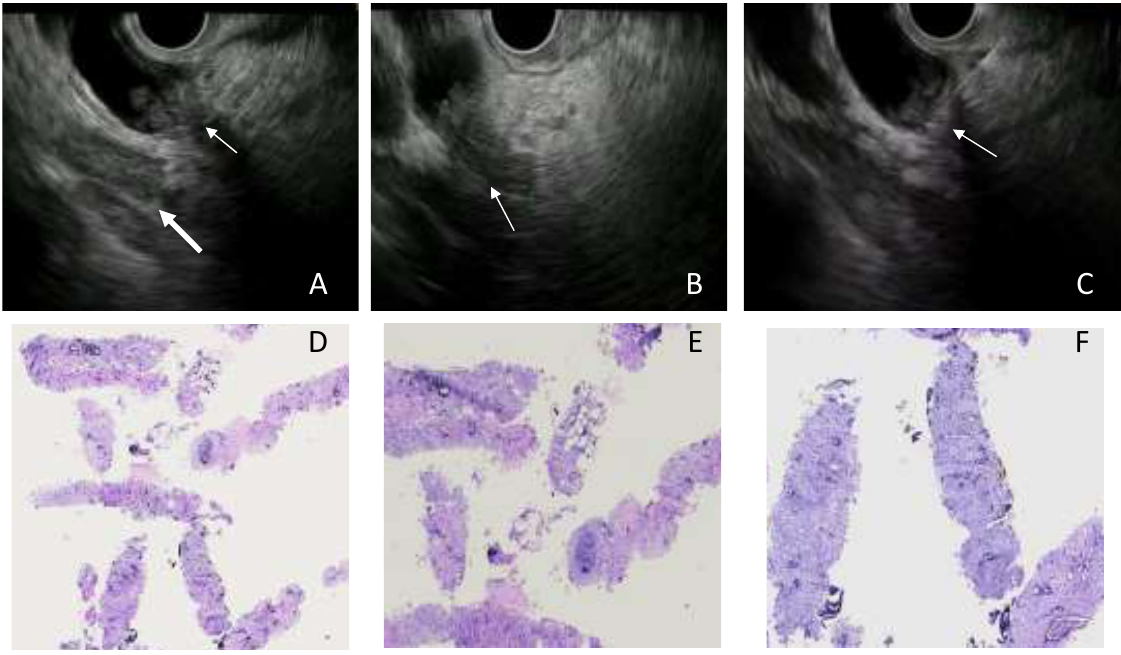
Figure 2. Case of medio-proximal biliary stricture. ( A – C ) At EUS, the biliary stenotic tract was clearly visible due to the thickening of the wall and vegetation inside the choledochus (( A , B ) thin arrow); lymphadenopathy was clearly visible ( A , thick arrow). EUS-FNA of the choledochus was performed to obtain tissue diagnosis ( C ). ( D – F ) Tissue samples collected by EUS-FNB stained with hematoxylin and eosin at different magnifications (( D ) 2 × ; ( E ) 4 × ; ( F ) 10 × ). Perineural invasion is visible in ( E ). 3.3. Performance of Endoscopic Procedures According to Location of Biliary Stenosis Diagnostic yield of ERCP with brushing or biopsy and EUS-FNA or EUS-FNB accord- ing to location of BS is shown in Table